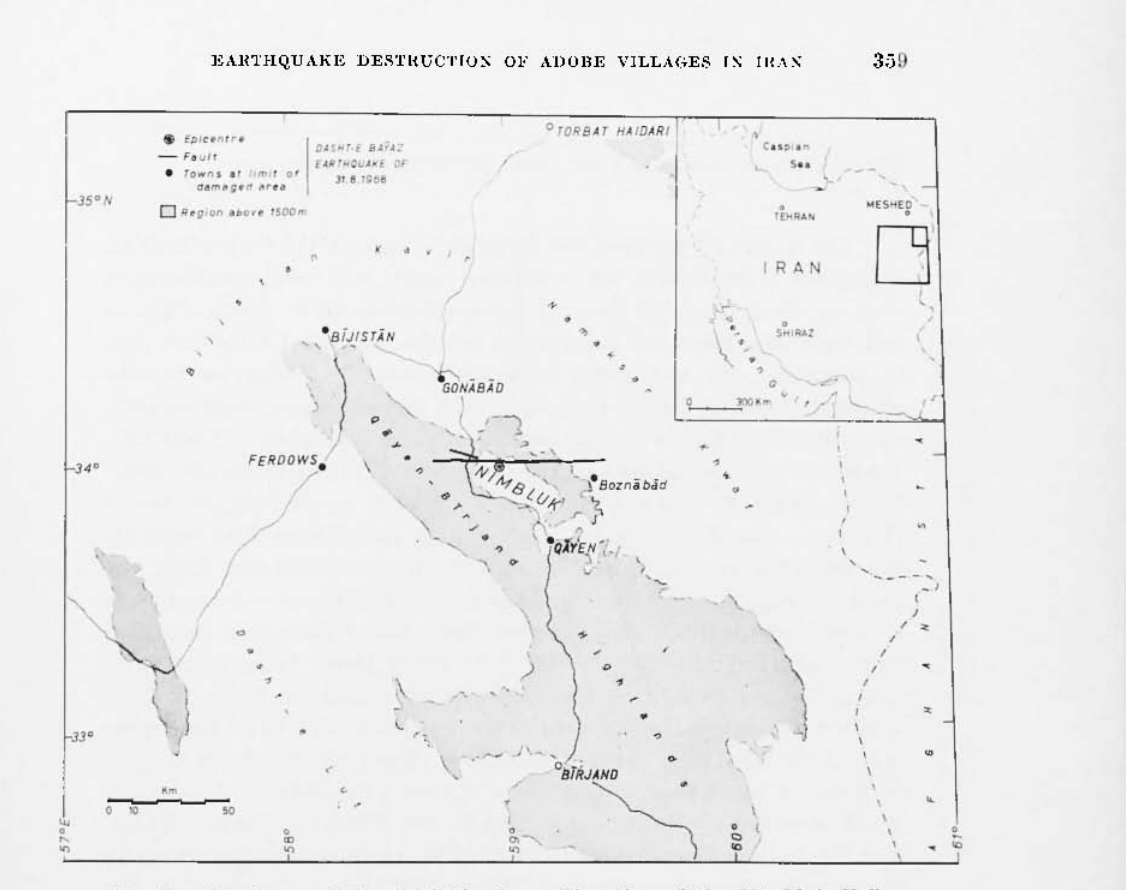
Fig. l - 'l'Ire QUFll-Birjun,l higlllun,ls al1(1 the Dasht-e Bayaz err.rtlHl'llIke or